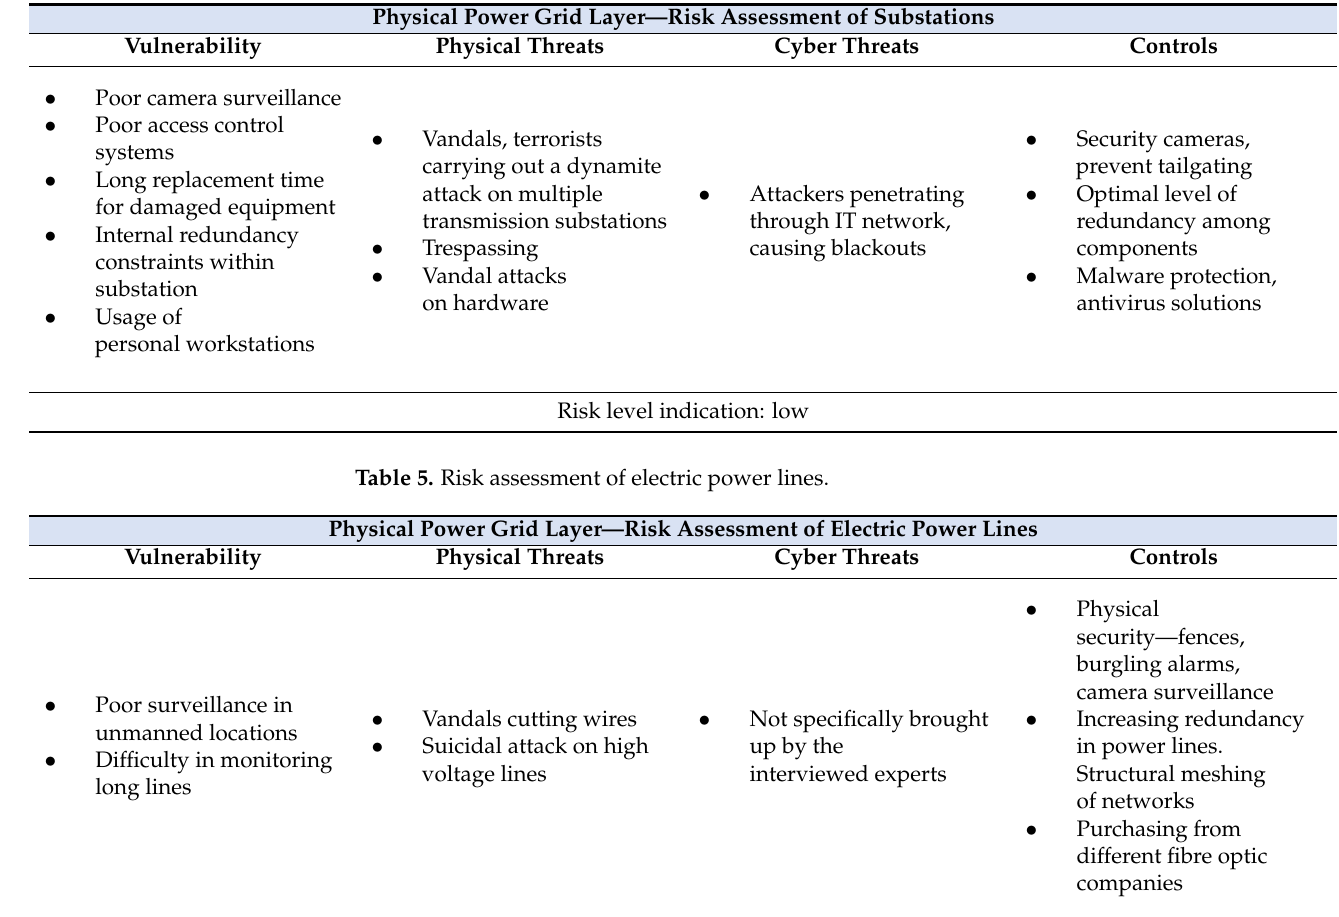
Table 4. Risk assessment of substations.